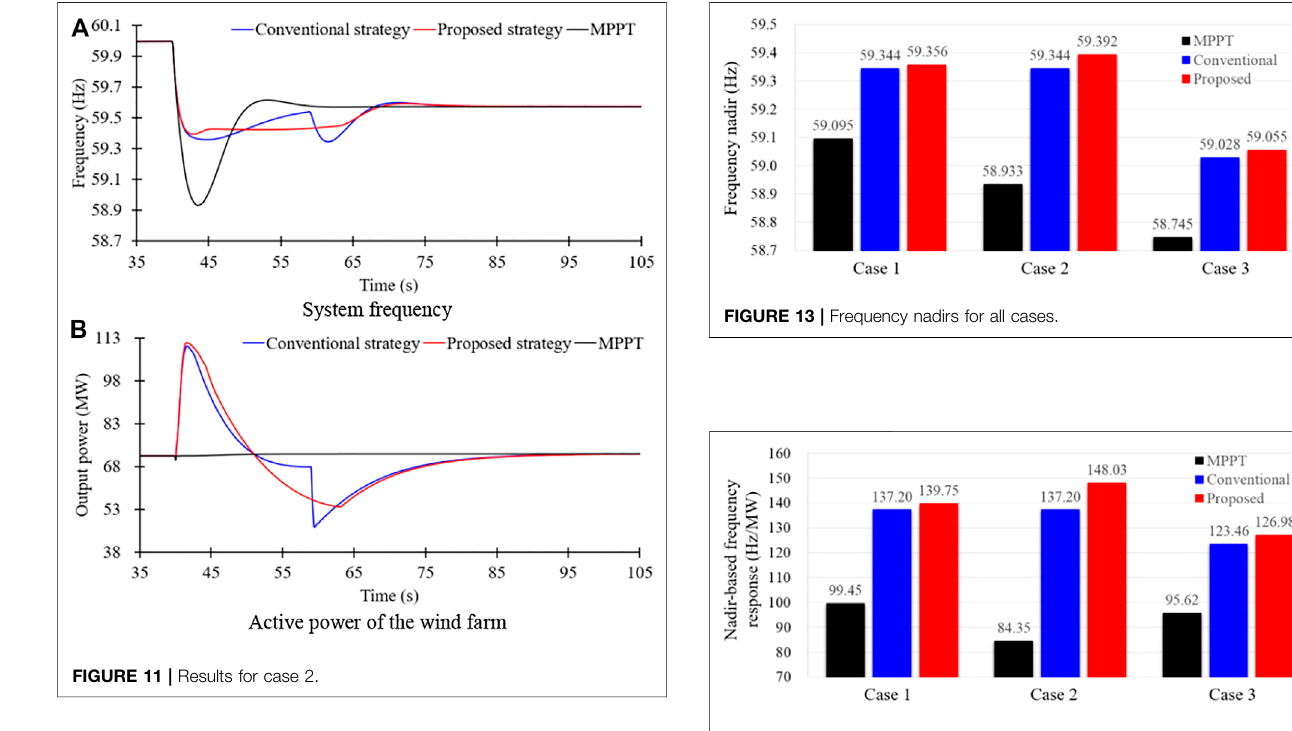
FIGURE 14 | Nadir-based frequency responses for all